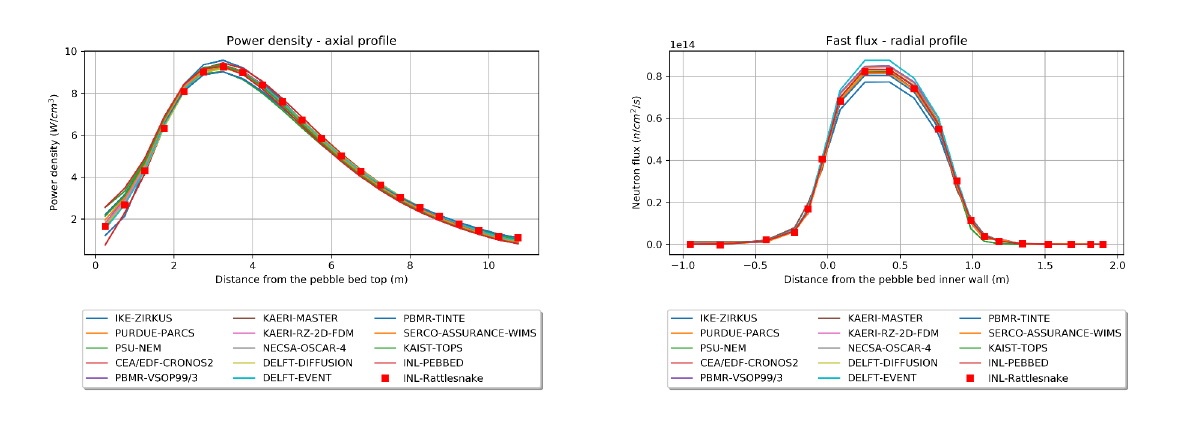
Figure 6: Power Density - Axial Profile Comparison